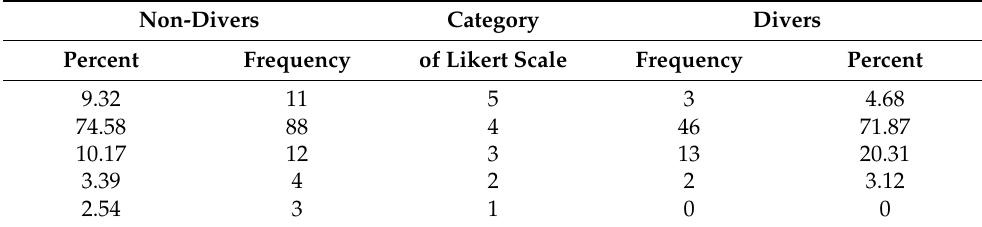
Table 10. Scuba diving impact on pain